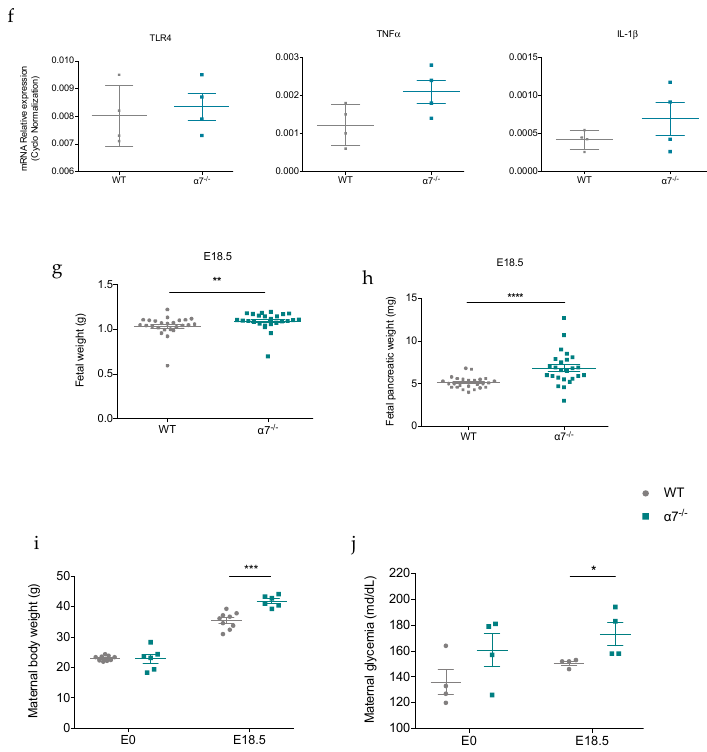
Figure 5. α 7 nAChR deficiency is associated to embryonic remodeling of pancreatic islet mass. Pancreata were harvested from α 7 − / − and WT control fetuses at E18.5, and α - and β -cell mass were measured by morphometric analysis after glucagon or insulin immunostaining. Illustrative images of insulin ( a ) or glucagon ( c ) staining in pancreas from a WT control (left) and α 7 − / − (right) fetus at E18.5 (Scale bare = 30 µ m). β -cell mass ( b , d ) α -cell mass in pancreatic sections of α 7 − / − fetuses at E18.5 are shown compared with WT controls. Pancreas fetal weight used to quantify β - and α -cell mass are expressed as mean ± SEM ( e ). At E18.5, fetal pancreas were analyzed for mRNA expression of pro-inflammatory markers such as TLR4, TNF α and IL-1 β ( f ). Gene expression levels were normalized to Cyclophilin A gene expression. Body ( g ) and pancreas ( h ) weight were measured in α 7 − / − and WT control fetuses at embryonic day 18.5 (E18.5). Maternal weight ( i ) and glycemia ( j ) were measured the morning on which a vaginal plug (E0.5) was present and at day 18.5 (E18.5) of the pregnancy. Each dot represents a mouse (grey dots for WT mice and green squares for α 7 − / − mice). All data are presented as mean ± SEM. Symbols *, **, *** and **** indicate a significant di ff erence compared to control WT using unpaired Mann–Whitney two-tailed test ( b , d , f–h , n = 4–25 / group, * p < 0.05; ** p < 0.01; *** p < 0.001 and **** p < 0.0001) and Multiple t tests ( i , j , n = 4–9 / group, * p < 0.05, *** p < 0.001).